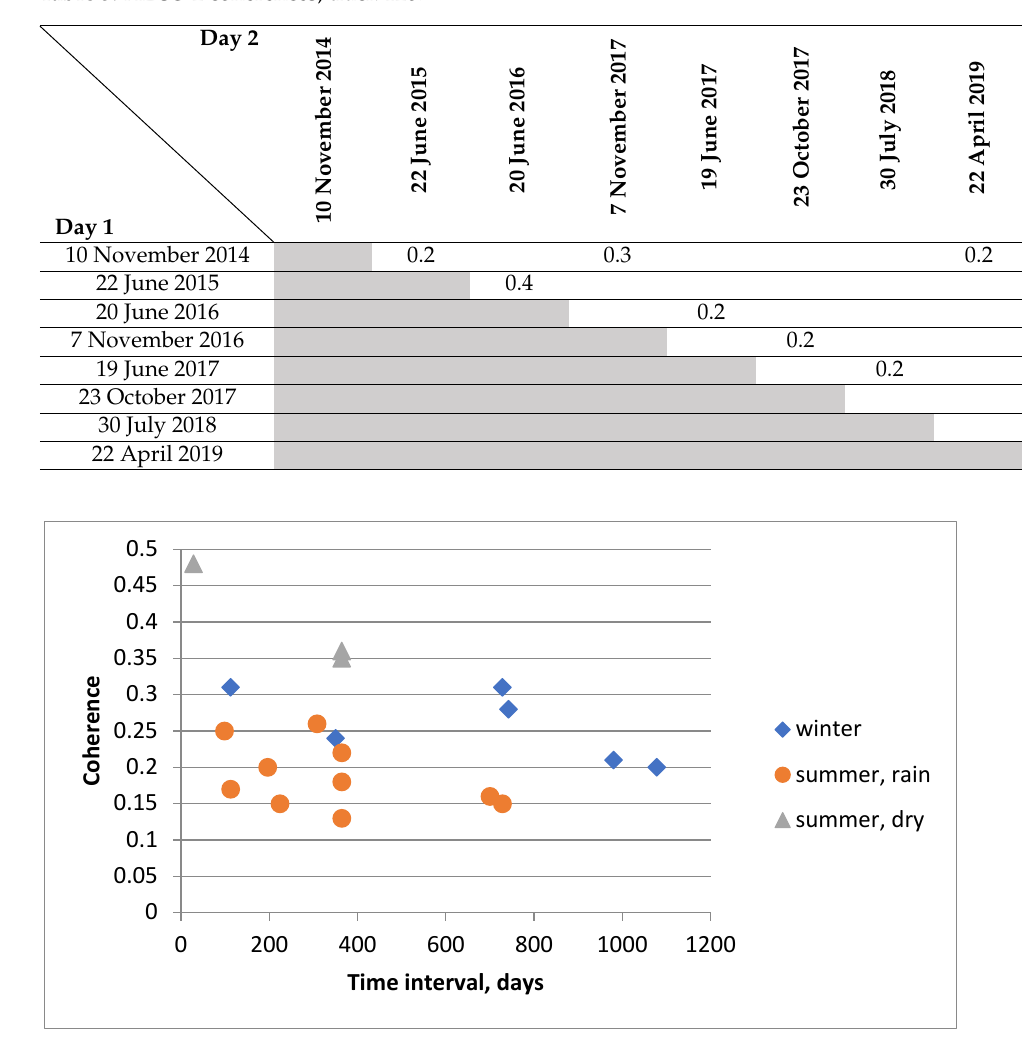
Table 5. ALOS-2 coherences, track 128.